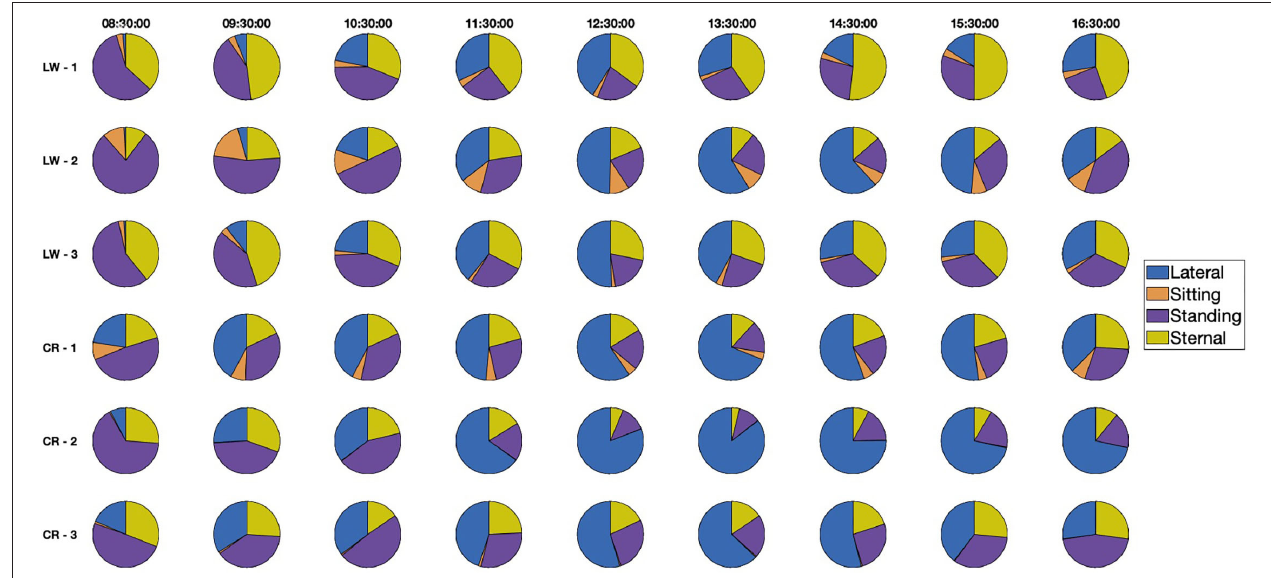
FIGURE 5 | Posture distribution as a function of time over the day. Each row corresponds to one animal and each column to one time period. Each time period is one hour length. Column title gives the start of the time period.